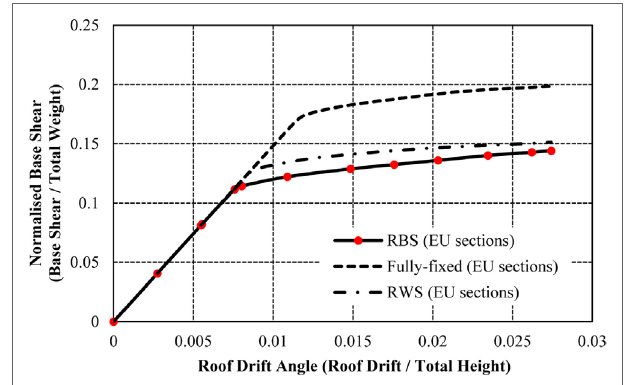
Figure 24 | Normalized capacity curve for 16-storey frame with fully fixed connections, reduced web sections (RWSs), and reduced beam sections (RBSs).